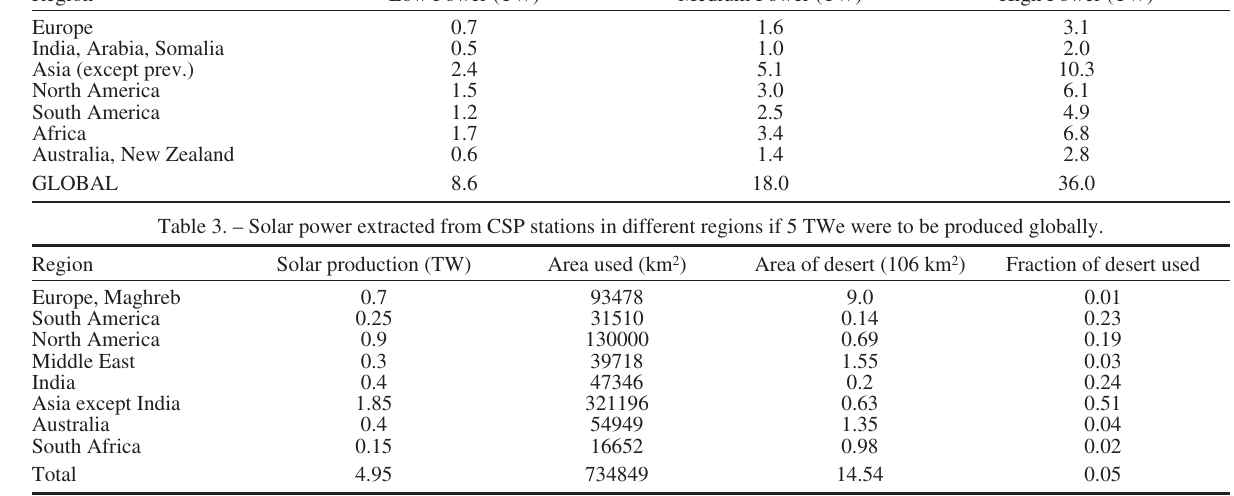
Table 2. – Wind potential in three scenarios of increasing occupation of continental and shelf surfaces. Region